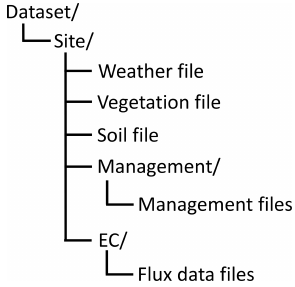
Figure 2. Folder structure of the dataset. A slash (“/”) denotes a